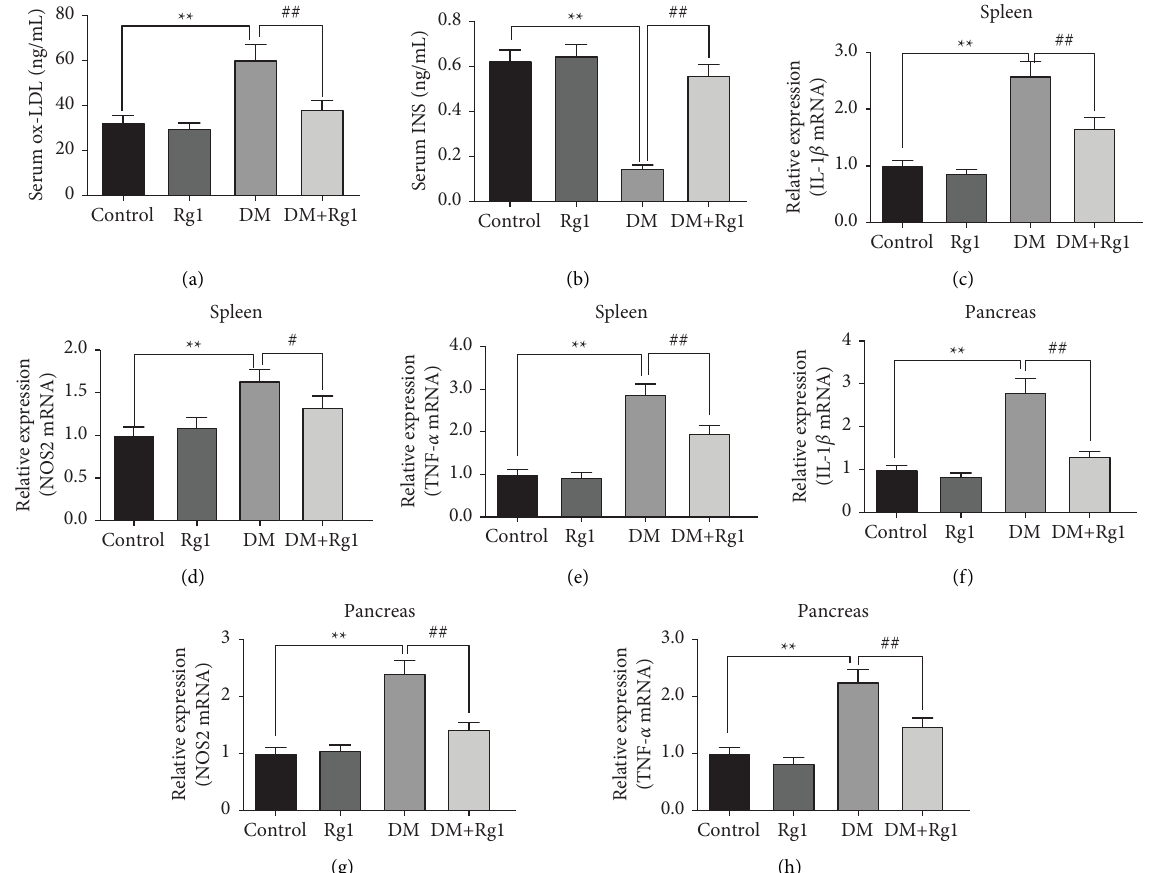
Figure 7: Te levels of ox-LDL and INS in the serum and the transcription levels of infammatory factors in the pancreas and spleen. (Mean ± SD) (a) Te levels of ox-LDL and (b) the degrees of INS in serum were detected by ELISA ( n � 6). (c–e) Te transcription level of infammatory factors in the spleen was detected by qRT-PCR ( n � 3). (f–h) Te transcription level of infammatory factors in the pancreas was detected by qRT-PCR ( n � 3). Te way of 2 − △△ Ct was used to calculate the relative expression of the target gene. Rg1 treatment in type 1 diabetes mice can inhibit serum ox-LDL and the transcription levels of infammatory factors in the pancreas and spleen and advance the serum INS. ∗∗ p < 0 . 01, vs. the control group; ns p > 0 . 05, ## p < 0 . 01 vs. the DM